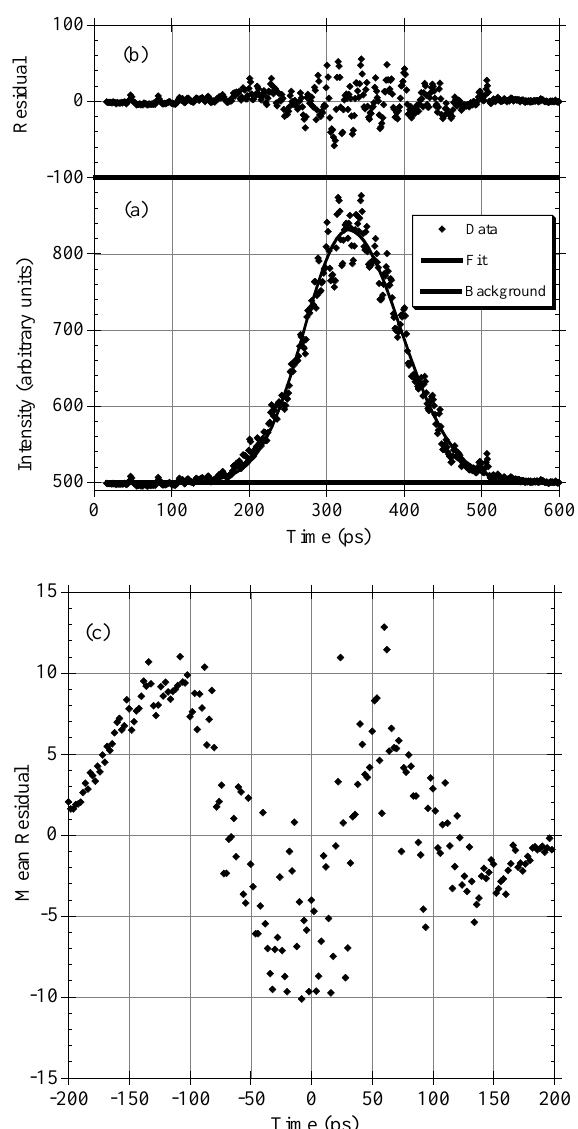
FIG. 19. A single data acquisition of the longitudinal bunch distribution fit to the mean stable distribution when the signal generator voltage is (a) 1 10 dBm and frequency is 309.9 kHz. (b) The residual from the mean distribution when the signal gen- erator voltage is 1 10 dBm. The mean residual for the octupole mode is plotted in (c).